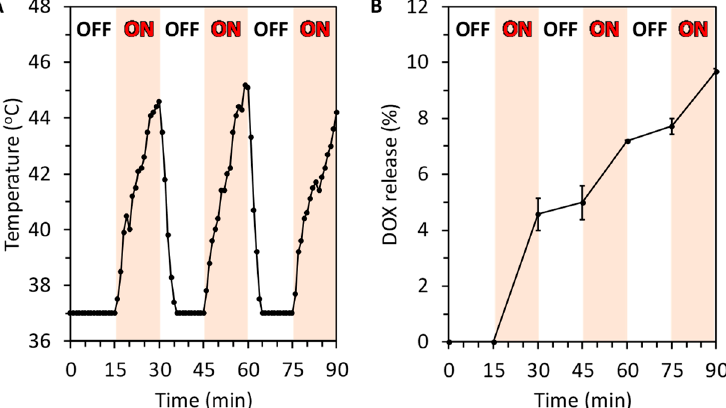
Figure 6. ( A ) Temperature change in MDC sponge-immersed in the cell culture medium in response to switching the AMF on and off. ( B ) DOX release from the MDC sponge when AMF was repeatedly applied and removed.